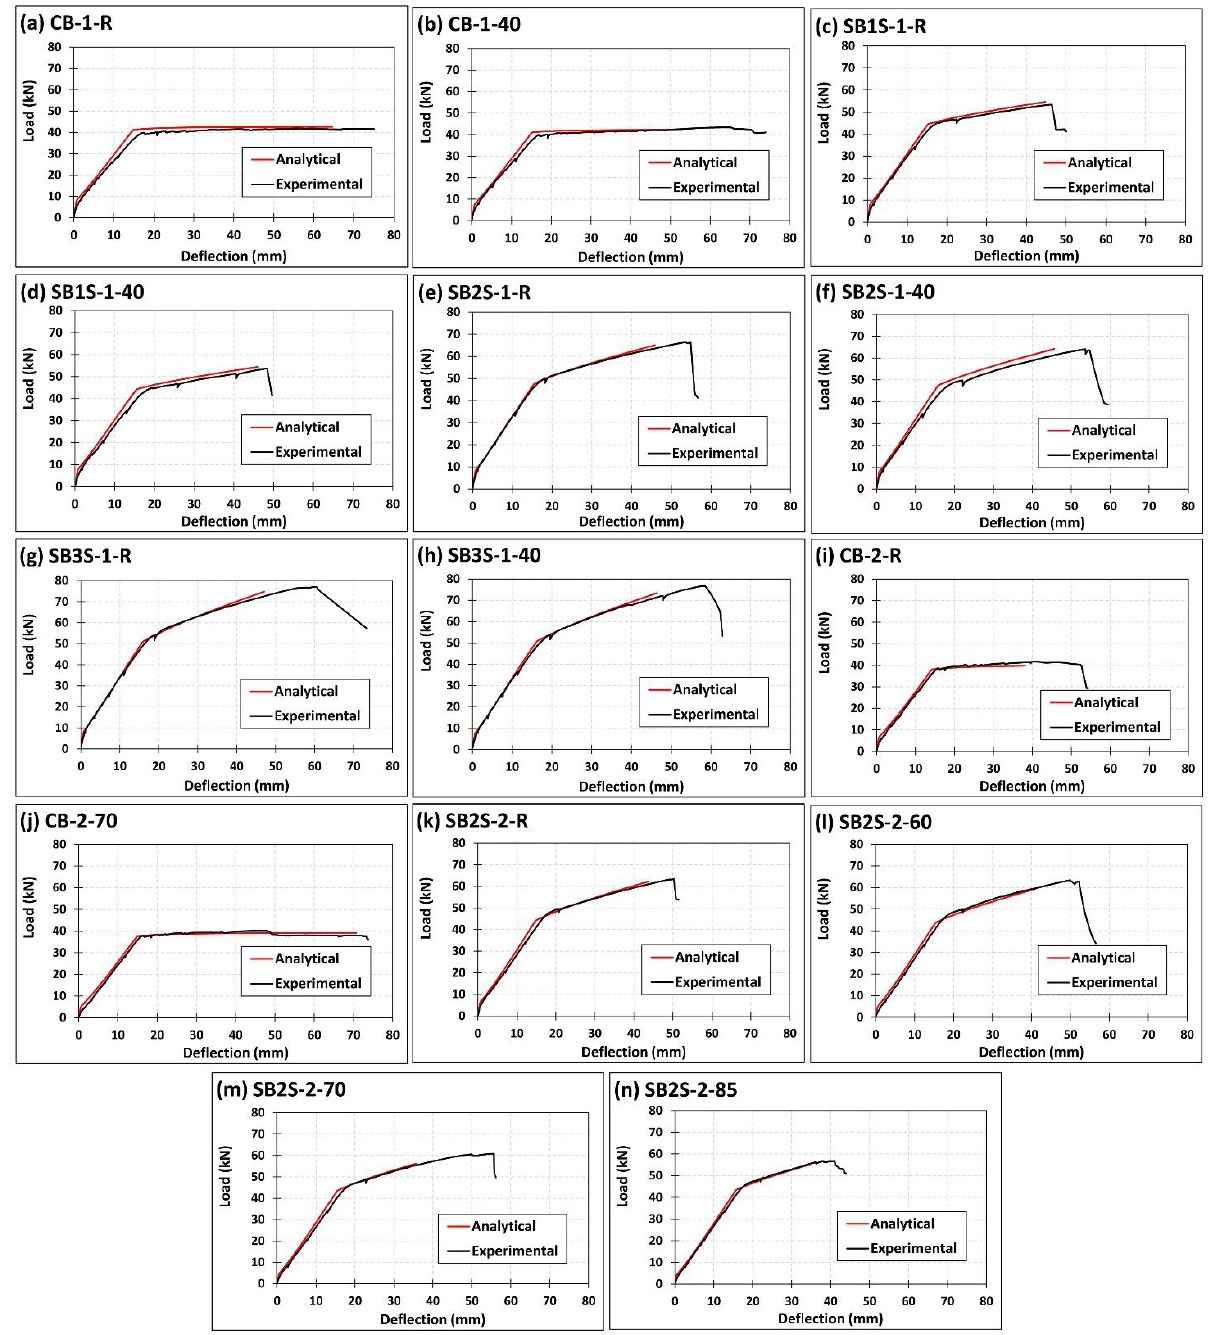
Figure 11. Comparison between experimental and analytical predictions on load–deflection curves of specimens ( a ) CB-1-R; ( b ) CB-1-40; ( c ) SB1S-1-R; ( d ) SB1S-1-40; ( e ) SB2S-1-R; ( f ) SB2S-1-40; ( g ) SB3S-1-R; ( h ) SB3S-1-40; ( i ) CB-2-R; ( j ) CB-2-70; ( k ) SB2S-2-R; ( l ) SB2S-2-60; ( m ) SB2S-2-70; and ( n ) SB2S-2-85.